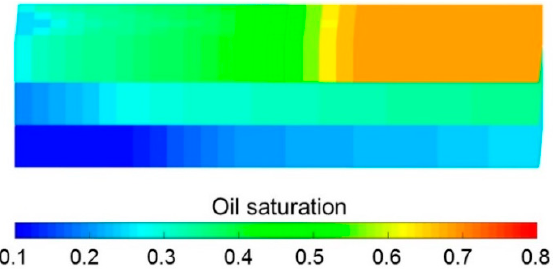
Figure 17. 3D remaining oil saturation distribution after cumulative injection volume of 1.67 PV of the simulation with a first-order dynamic degradation rate constant of 0.100 day − 1 .